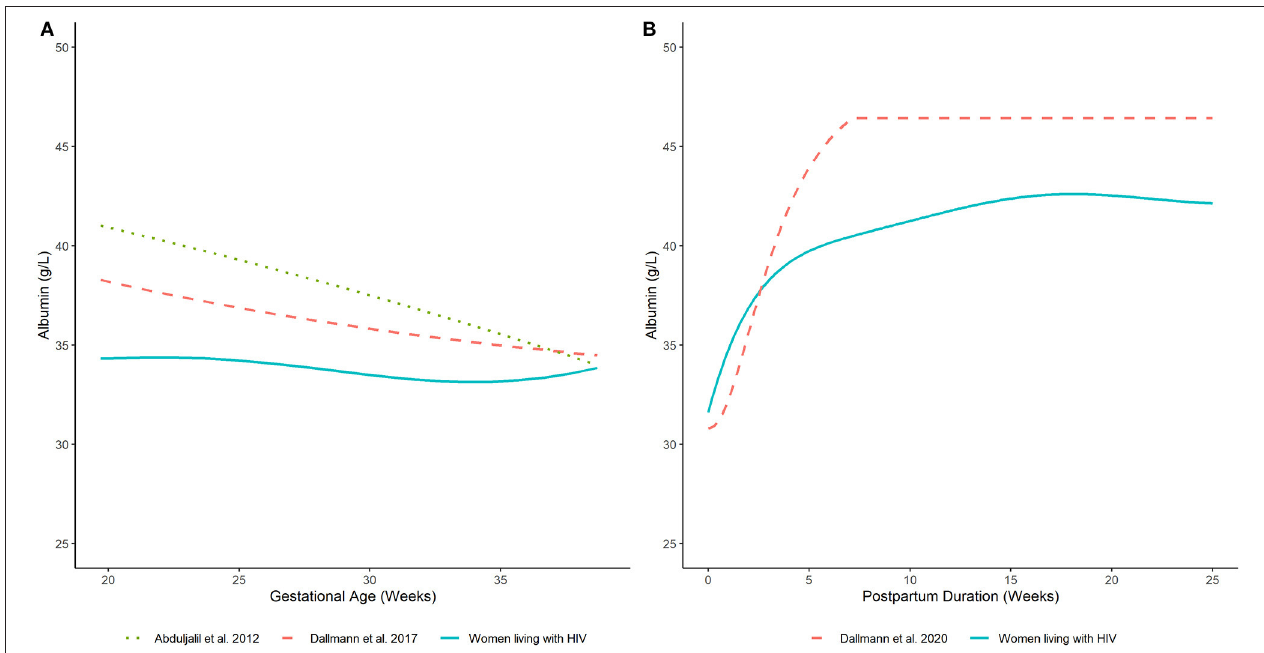
FIGURE 2 | Serum albumin concentrations in (A) pregnant and (B) postpartum women estimated by our analysis (women living with HIV) and other published equations (women without HIV infection) (7, 8, 17). Lines depict (arithmetic) mean albumin concentration estimates generated by competing models.